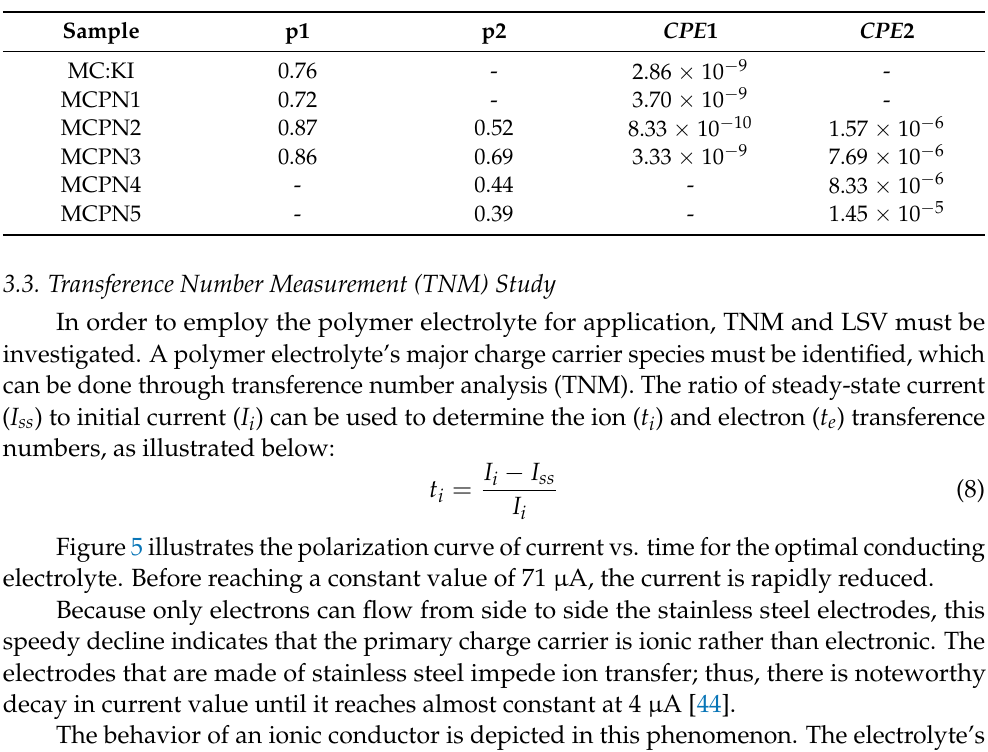
Table 2. Calculated different circuit parameters for the prepared polymer